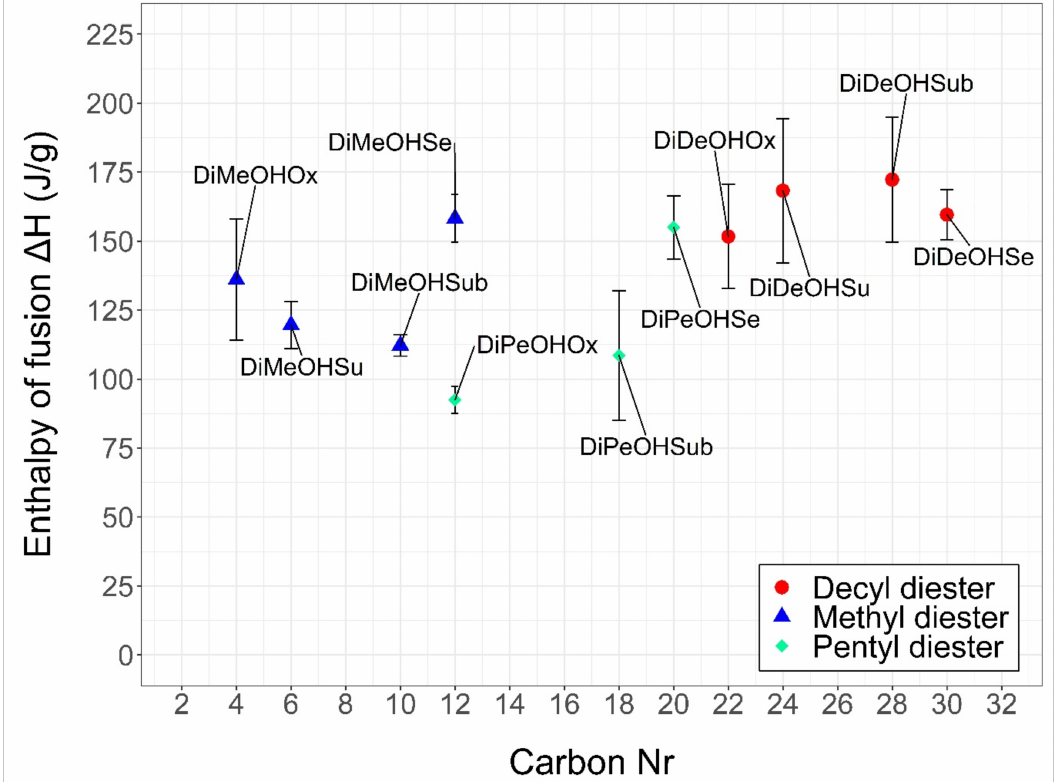
Figure 4. Scatter plot of the average enthalpies of fusion ∆ H plotted against the carbon numbers of all diesters reported in this study. The diesters have been grouped based on the corresponding precursor alcohol. Methyl diesters are indicated in blue, pentyl diesters are indicated in green, and decyl diesters are indicated in red. The error bars represent the standard deviation between the means of three replicas for each